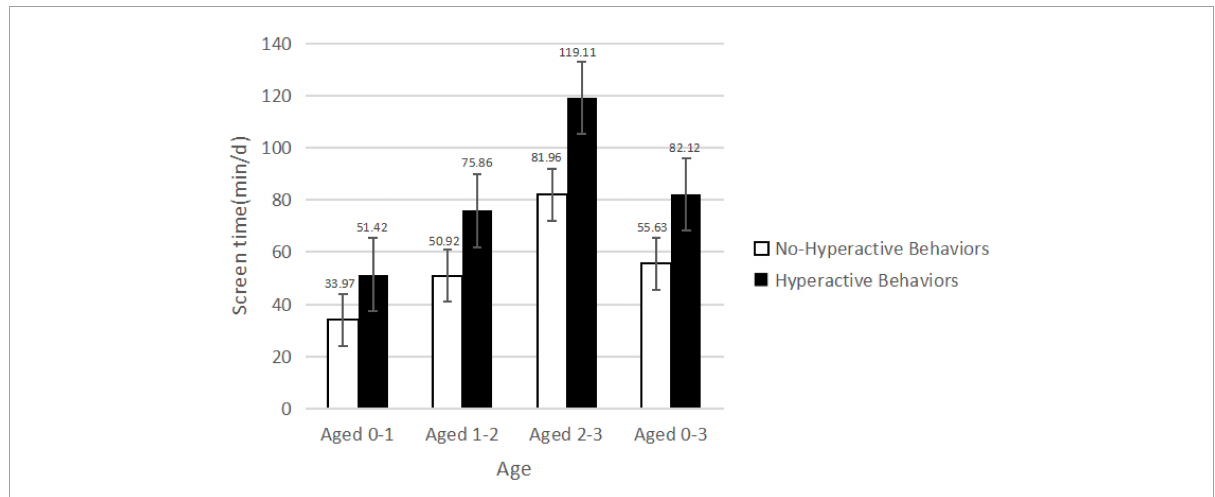
FIGURE1 Comparison of screen time at different ages between children with hyperactive behaviors and children without hyperactive behaviors.